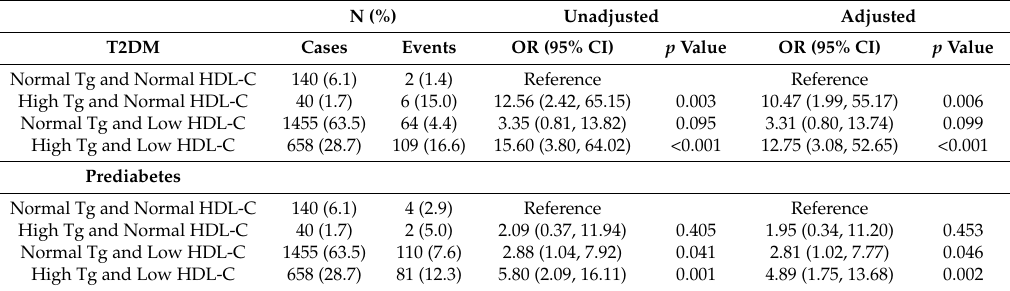
Table 3. Associations of combined Tg and HDL-C status according to different combinations of high/low categories of these two lipids among those with T2DM (n = 181) and prediabetes (n = 197). N (%) Unadjusted Adjusted T2DM Cases Events OR (95% CI) p Value OR (95% CI) p Value Normal Tg and Normal HDL-C 140 (6.1)